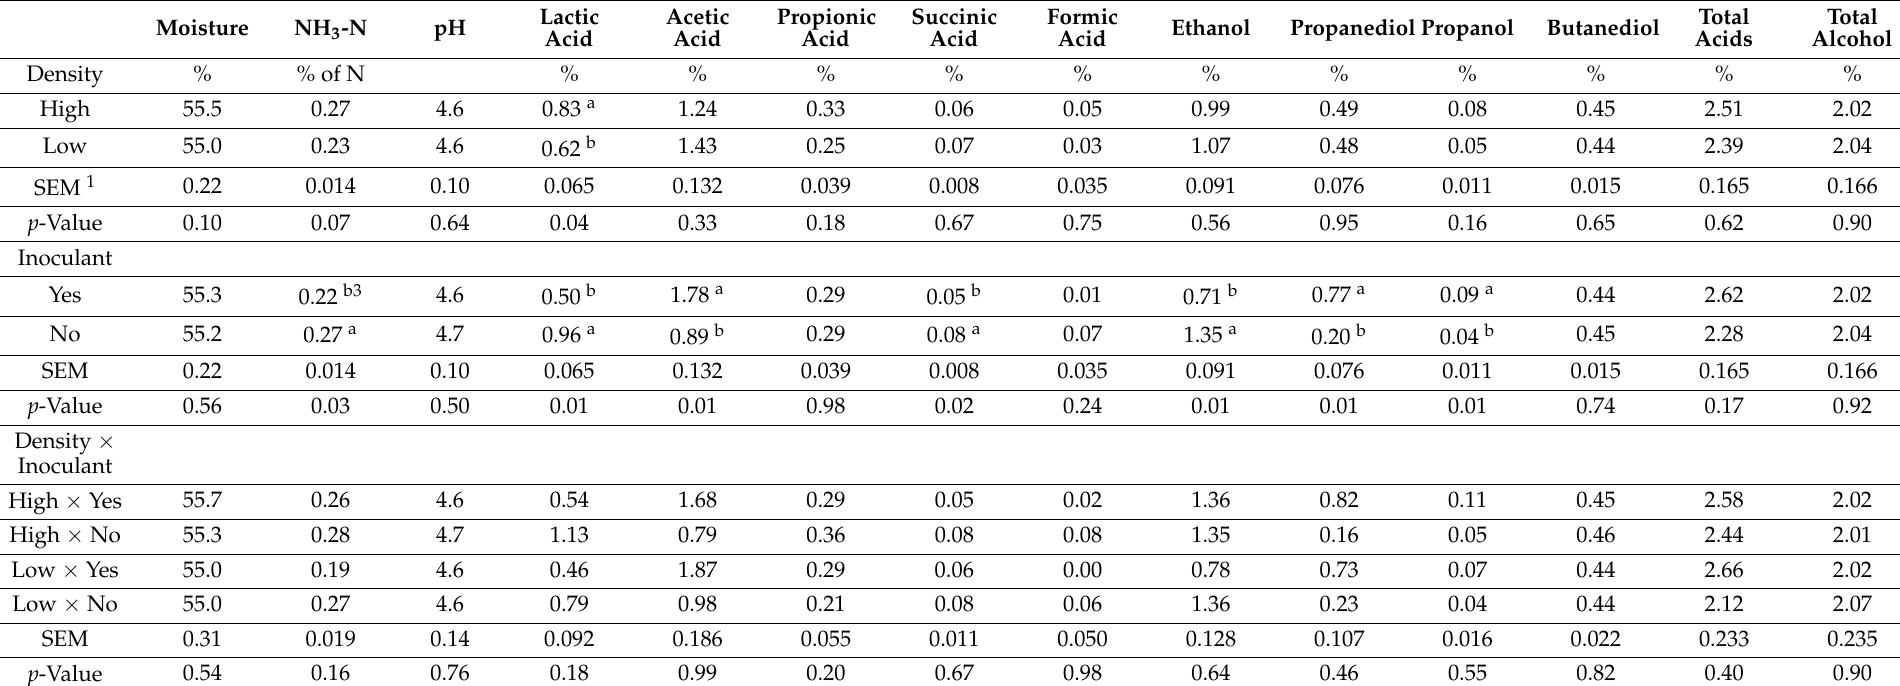
Table 3. Fermentation values for elderberry silage by main effect and interaction of density and inoculation